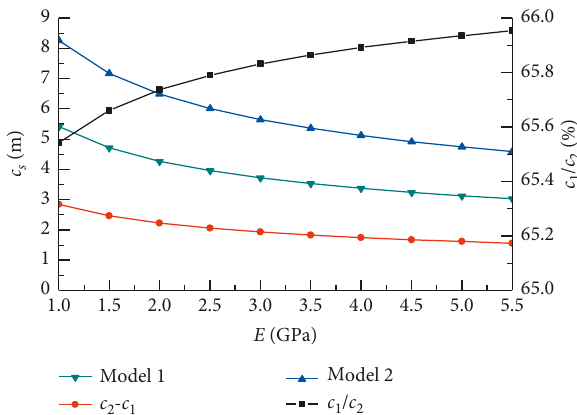
Figure 10: Diagram of minimum thickness with the elastic modulus of the orebody.